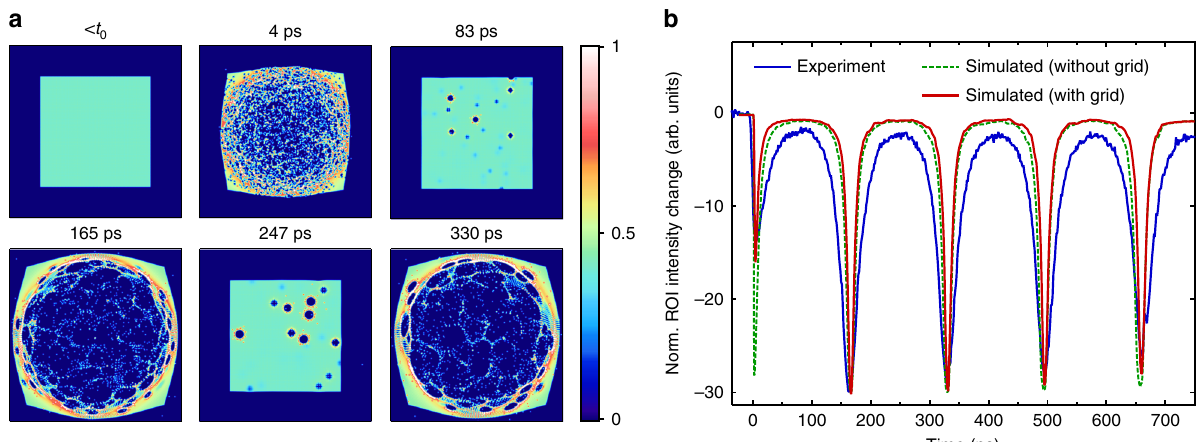
Fig. 9 Probe image simulations. a Simulated grid images based on snapshots from the numerical N -body simulation. The sides of the images are 24 μ m. Each electron on the detector is represented by a Gaussian kernel with a width of three pixels. b Simulated and experimental ROI difference intensity traces. The traces have been normalized to the second peak at 165 ps. The dashed green curve represents a calculation without a copper grid (no absorption of electrons, no image charges). The red curve includes the